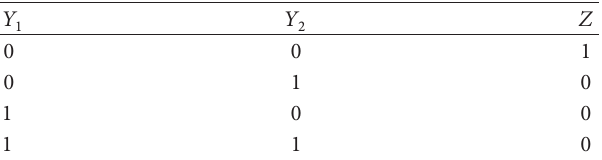
Table 1: Truth table of a NOR